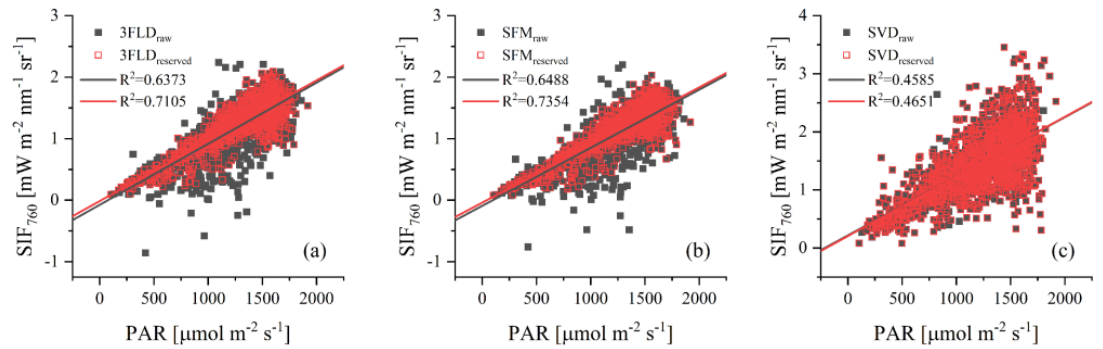
Figure 8. The relationship between PAR and SIF retrieved by the ( a ) SFM, ( b ) 3FLD, and ( c ) SVD methods from 17 days across the measurement period. Black square dots represent the retrieved SIF at 760 nm by SFM, 3FLD, and SVD. Red square circles represent the reserved SIF. The PAR values were the average of the high-frequency PAR values during the L measurements.